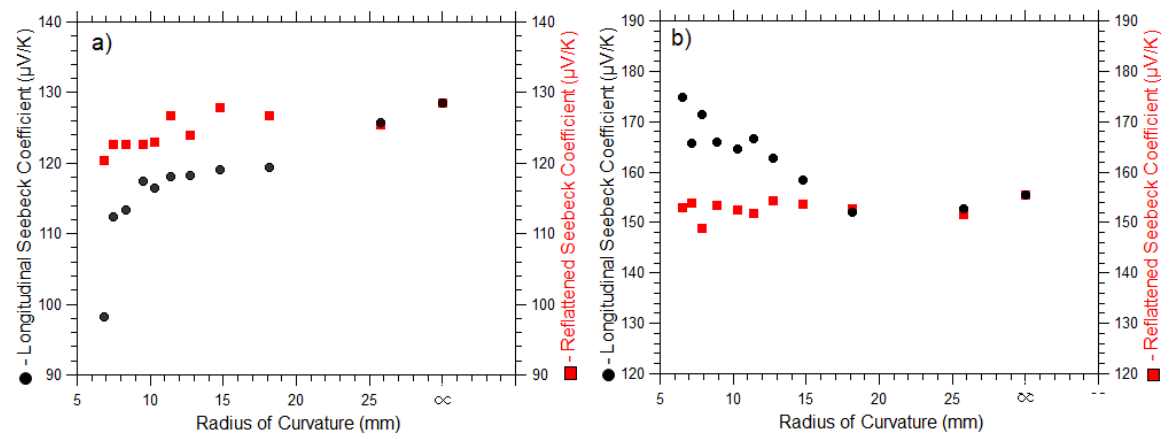
Figure 8. ( a , b ) Variation of the longitudinal and re-flattened Seebeck coefficient as a function bending radius measured at a fixed temperature of 60 °C for n-type samples ( a ) under tensile strain, ( b ) under compressive strain.